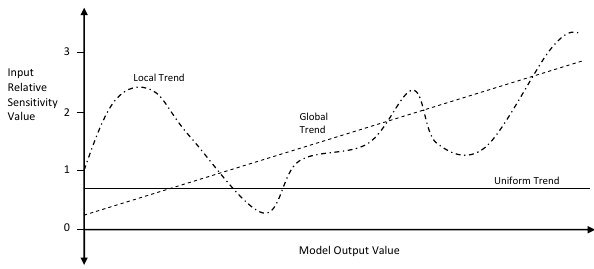
Fig. 3. Examples of relative sensitivity trends on the global–local continuum. The relative sensitivity value computed for any given point in the model output range indicates its response ratio magnitude at that point (i.e. the relative rates of change in the input and output). Trends can then be fitted through the scatter of points generated by computing the relative sensitivity for any set of input / output records. Uniform trends are indicative of models where the local input / output response ratios do not vary across the range of model outputs. Global trends are indicative of input / output response ratios that vary in a consistent manner. Local trends exhibit high variability in their input / output response ratios.